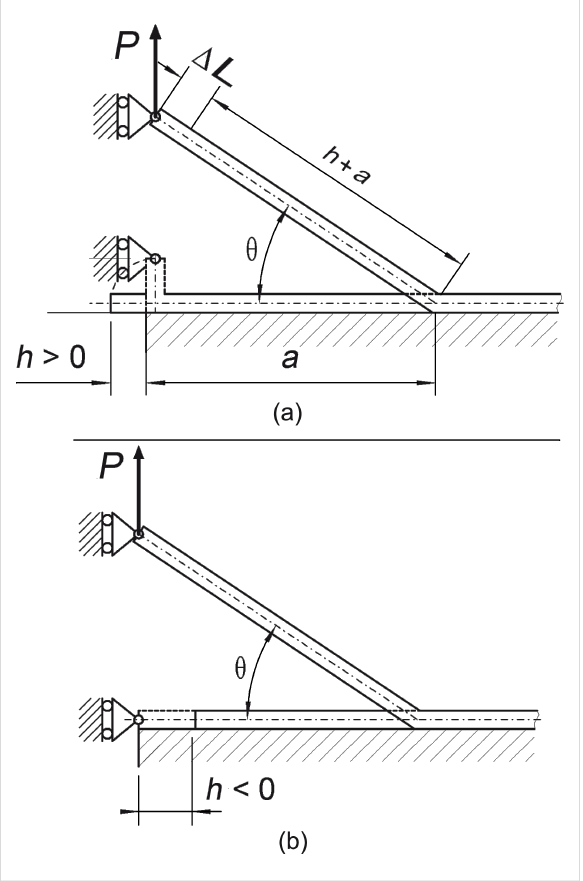
Figure 1: Double peeling of a tape. Initial configuration (a): a length h of the tape is not attached to the substrate and it is rotated